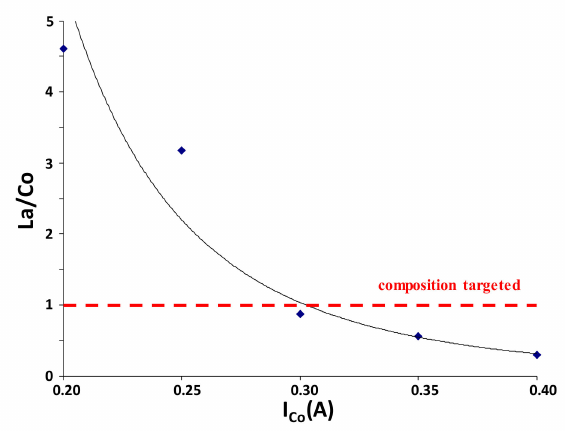
Figure 1. Evolution of the atomic La / Co ratio measured by Energy Dispersive Spectroscopy (EDS) as a function of the current dissipated on the Co target (I La = 1 A). The total pressure is 1.5